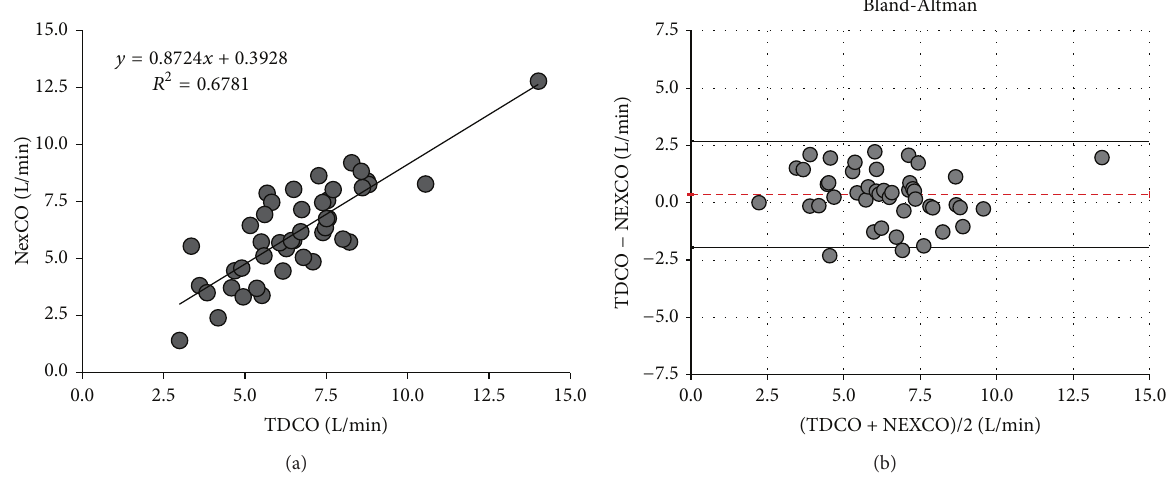
Figure 1: Cardiac output measurements: TDCO versus NexCO. Only one average value per patient is plotted. (a) Regression analysis. (b) Bland-Altman analysis. Patient averages with the mean cardiac output ranges ( 𝑥 -axis) and bias errors ( 𝑦 -axis) during the 8-hour study period. Dotted line indicates bias and solid lines indicate lower and upper limit of agreement. NexCO: Nexfin cardiac output. TDCO: thermodilution cardiac output.